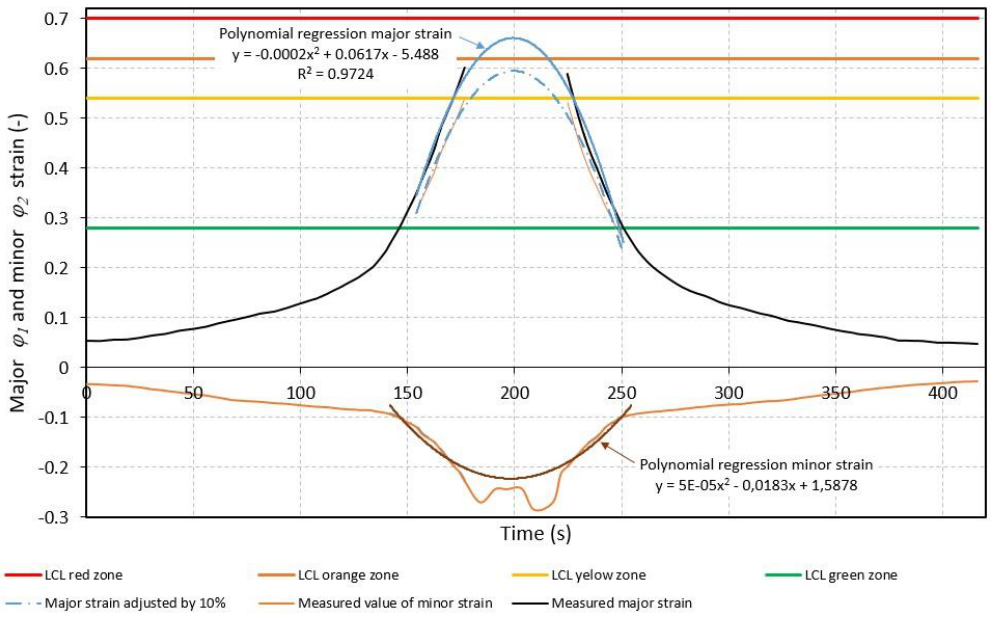
Figure 14. Dependence of the major and minor strain on time with indicated zones. Based on the values of the major and the minor strains measured in the yellow zone, the left parts of the FLC for the base materials (BM) and the laser-welded materials (LW) were constructed as shown in Figure 15 and Figure 16, respectively. The solid red line indicates the upper limit values of the FLCs, and the green line represents the curves re- duced by 10%. The upper target strain φ 1 value required to convert the blank into the finished surface part of the catalytic converter is indicated by a solid blue line for φ 2 from − 0.1 to 0 in the FLD, and the lower target strain φ 1 value for the φ 2 from − 0.1 to 0 is indi- cated by a dashed blue line. Figure 15 shows that the target strain values for manufactur- ing the catalytic converter and muffler from both AISI 304 BM and AISI 304 LW are below the FLC specified for the yellow area, i.e., 10% below the upper limit value determined from strain values measured on samples with radii of R5, R17, and R25, as listed in Table 5. This means that these parts should be manufacturable from both AISI 304BM and AISI 304 LW without the risk of failure or excessive wall thinning.